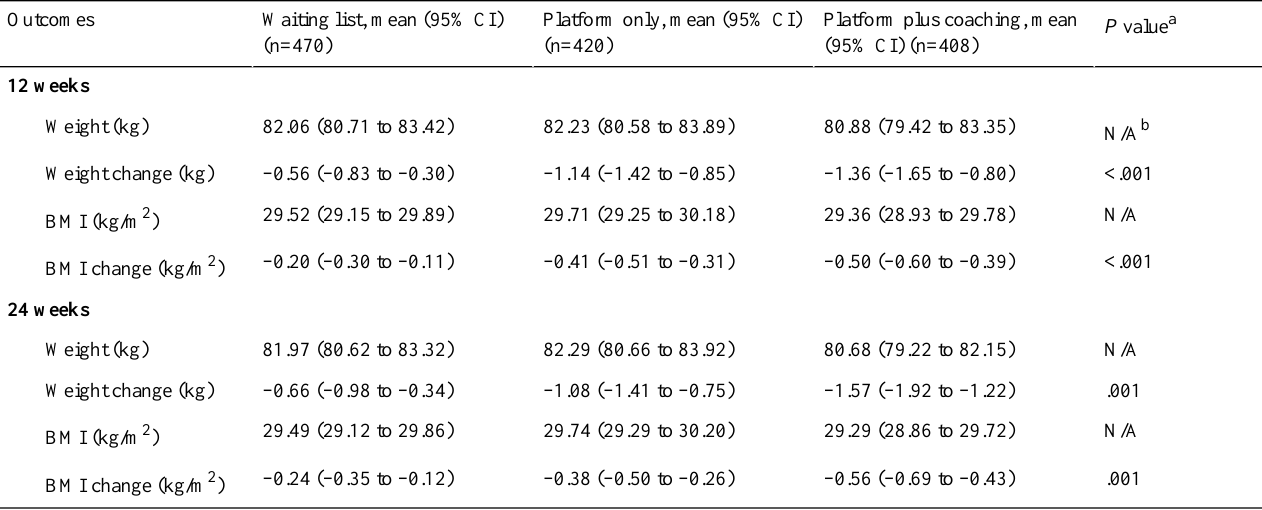
Table 2. Primary outcomes after 12 and 24 weeks of follow-up according to intention-to-treat analysis.